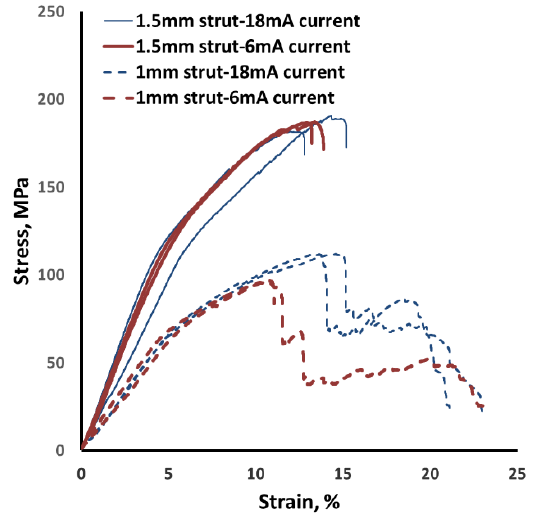
Figure 17. Effect of strut size on compressive properties in γ -TiAl porous structures produced using a standard scan strategy (Note: This scan strategy failed to build 0.5 mm strut samples as indicated in Table 4). Table 4. Compression test results for different porous designs.